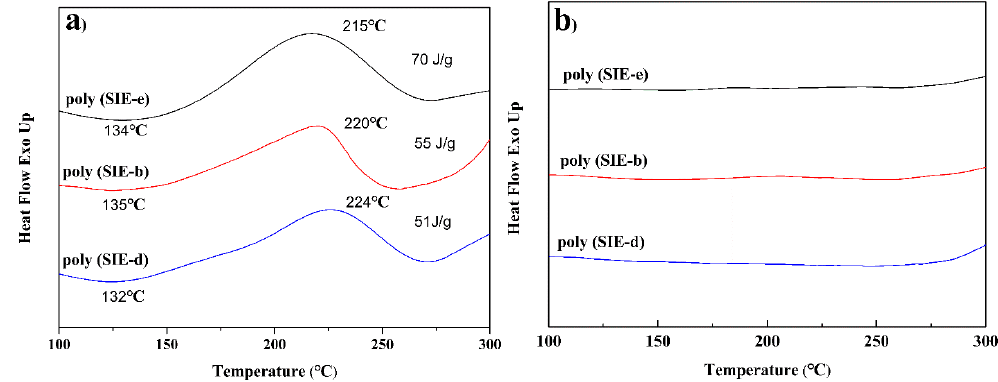
Figure 6. DSC heating curves for different benzoxazine oligomers ( a ); Non-isothermal DSC thermograms for the cured benzoxazine oligomers ( b ).